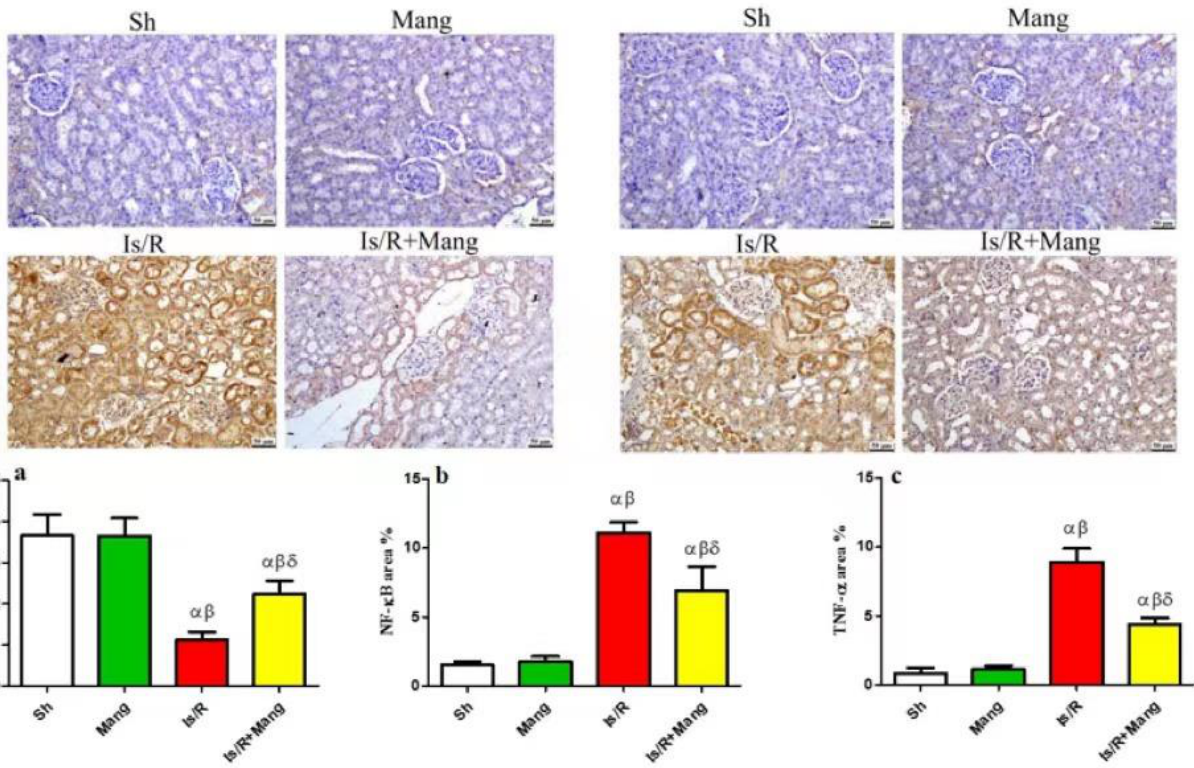
Figure 4. Mang’s (20 mg/kg, i.p) impact on renal ( a ) PPAR- γ mRNA protein expression as a signaling molecule, as well as IHC of ( b ) NF- κ B p65, and ( c ) TNF- α protein expression as inflammatory parameters. Data were articulated as the mean ( n = 7) ± SD, p value < 0.05 is significant. As compared with sham ( α ), Mang ( β ), and Is/R ( δ ) treated